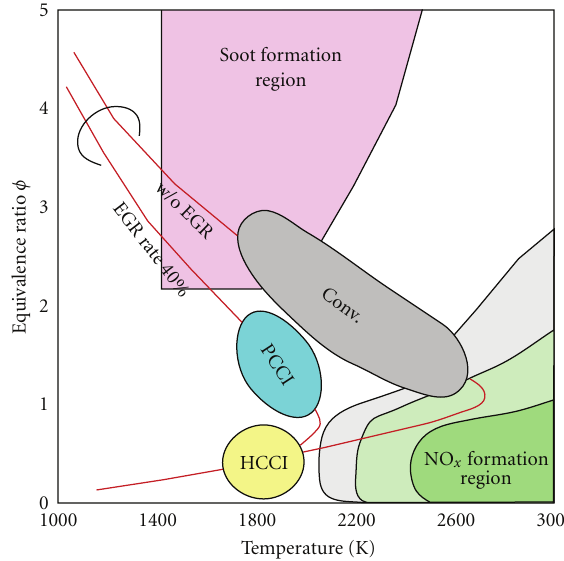
Figure 1: NO x -soot map of conventional Diesel, PPCI, and HCCI combustion